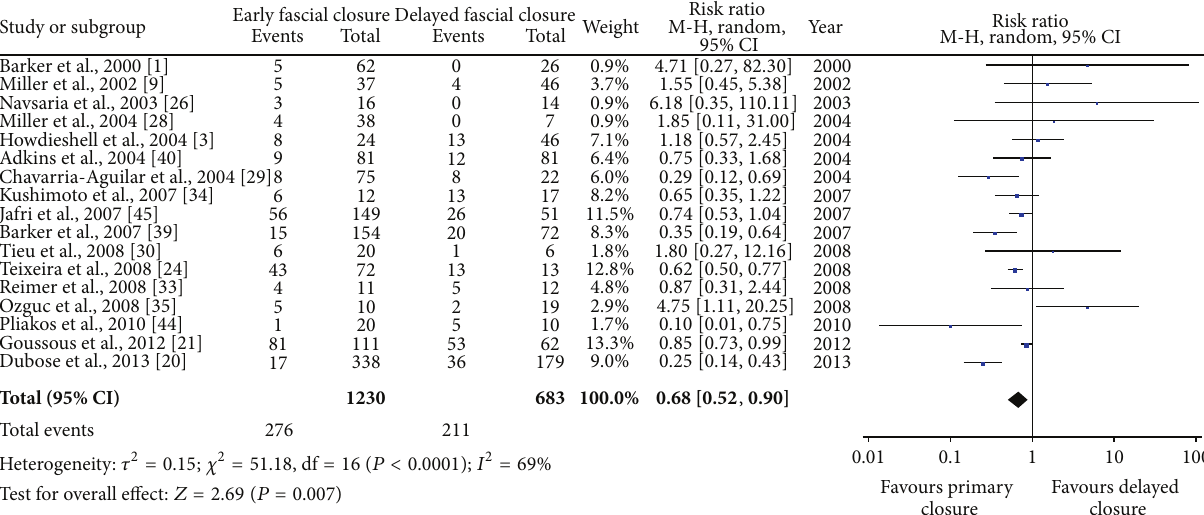
the period of follow-up was covered with a great distribution, ranging from 0.5 to 3.0